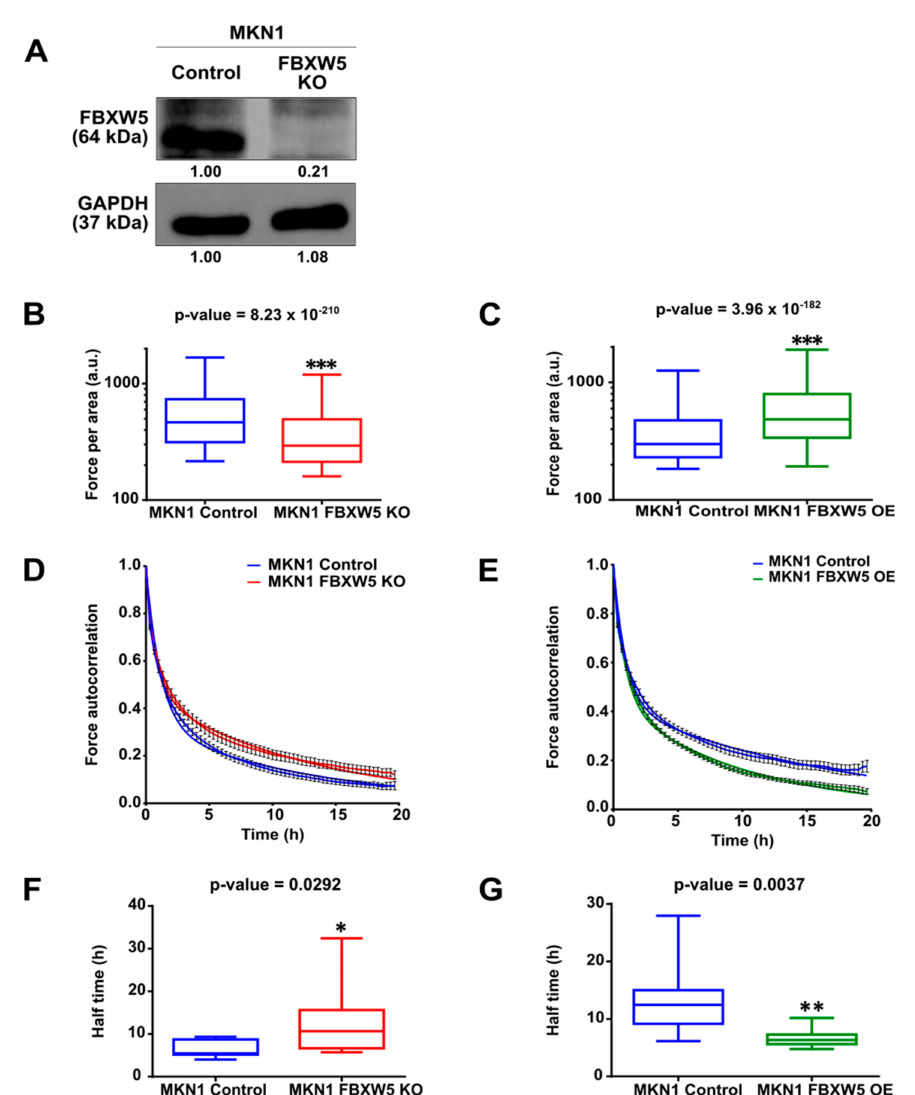
Figure 3. ( A ) Western blot analysis of FBXW5 protein expression in MKN1 control and MKN1 FBXW5 KO (knockout) cells. GAPDH served as the loading control. At least three independent experiments were performed. ( B ) Quantification of cellular traction forces of MKN1 control and MKN1 FBXW5 KO cells represented by box plots (*** p -value = 8.23 × 10 − 210 ). ( C ) Quantification of cellular traction forces of MKN1 control and MKN1 FBXW5 OE cells represented by box plots (*** p -value = 3.96 × 10 − 182 ). ( D ) Temporal dynamics of force application in MKN1 control and MKN1 FBXW5 KO cells plotted as mean ± SEM autocorrelation coe ffi cient of the magnitude of forces per area over time. ( E ) Temporal dynamics of force application in MKN1 control and MKN1 FBXW5 OE cells plotted as mean ± SEM autocorrelation coe ffi cient of the magnitude of forces per area over time. ( F ) Halftimes of fitted autocorrelation functions in MKN1 control and MKN1 FBXW5 KO cells represented by box plots (* p -value = 0.0292). ( G ) Halftimes of fitted autocorrelation functions in MKN1 control and MKN1 FBXW5 OE cells represented by box plots (** p -value =